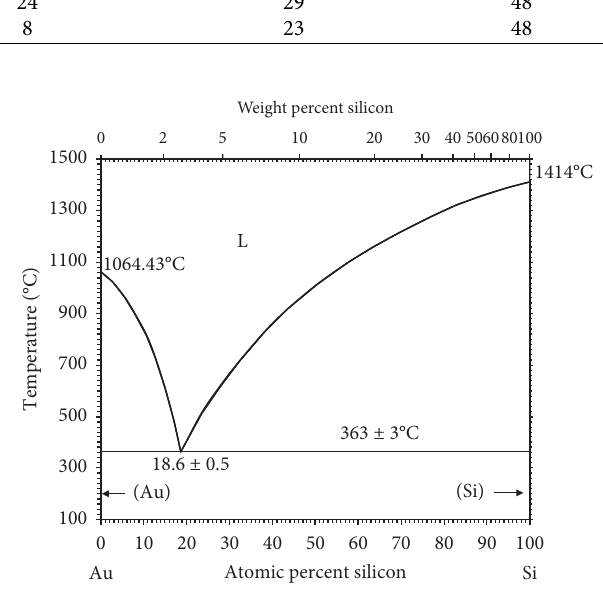
Figure 9: Binary phase diagram of Au-Si system [57]. Table 2: Properties of eutectic Au-Si and Au-Ge solder alloys [58].